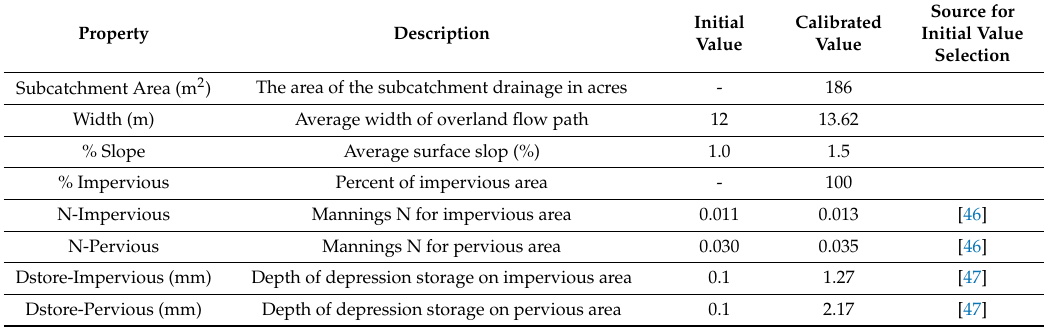
Table 2. Subcatchment properties used in the Environmental Protection Agency (EPA) Stormwater Management